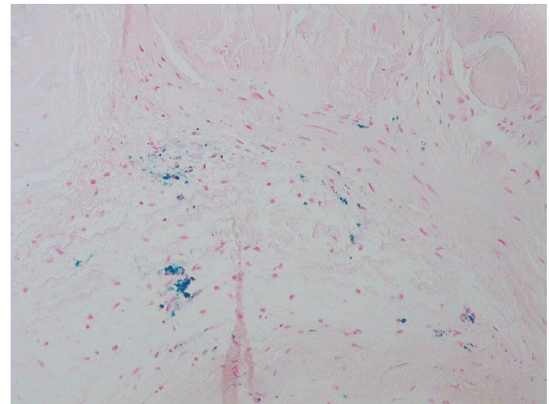
Fig. 3 Microscopic view of the pigmented valve with Perls’ blue. The blue colour indicates the presence of iron